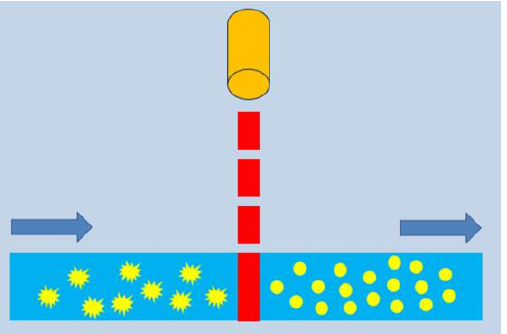
Figure 1. Scheme of pulsed laser irradiation of a nanoparticle colloid moving in a